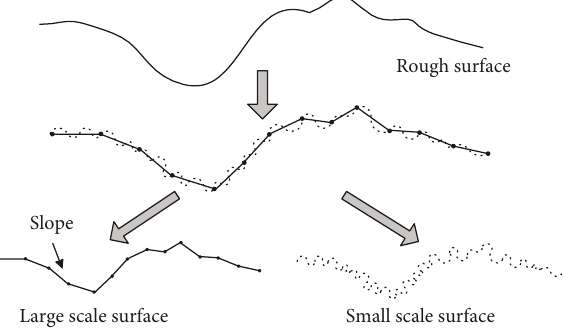
Figure 3: The schematic diagram of the two-scale model.